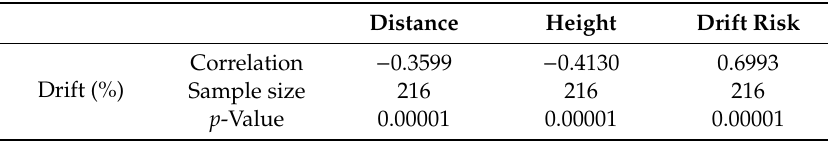
Table 9. Results of Spearman rank correlation